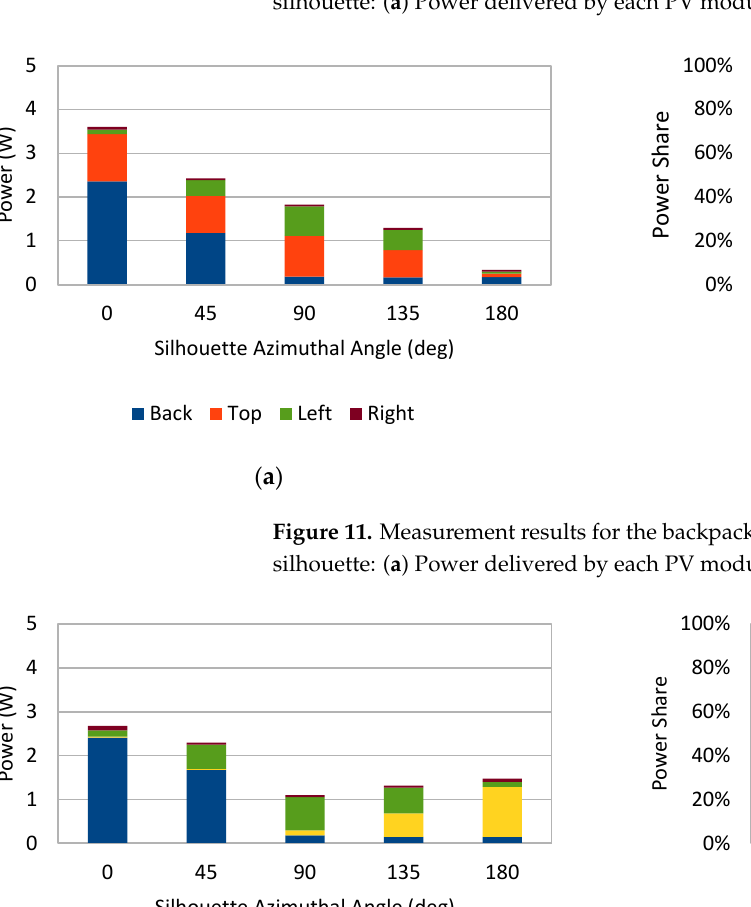
Figure 10. Measurement results for the backpack option 1 as functions of the azimuthal angle of the silhouette: ( a ) Power delivered by each PV module; ( b ) Power share of each PV module.